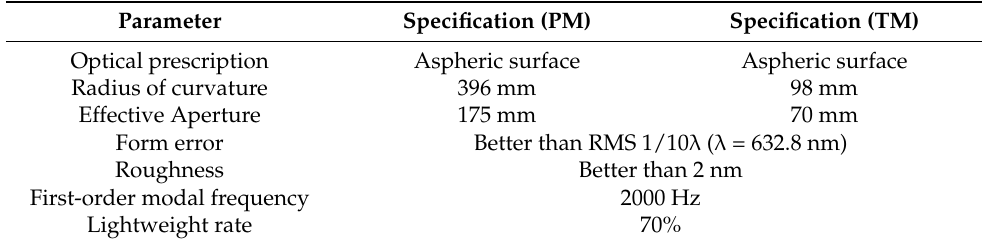
Figure 2. Schematic diagram of the relative position for the PM and the TM. Table 2. Parameters and specifications for the mirror with compound